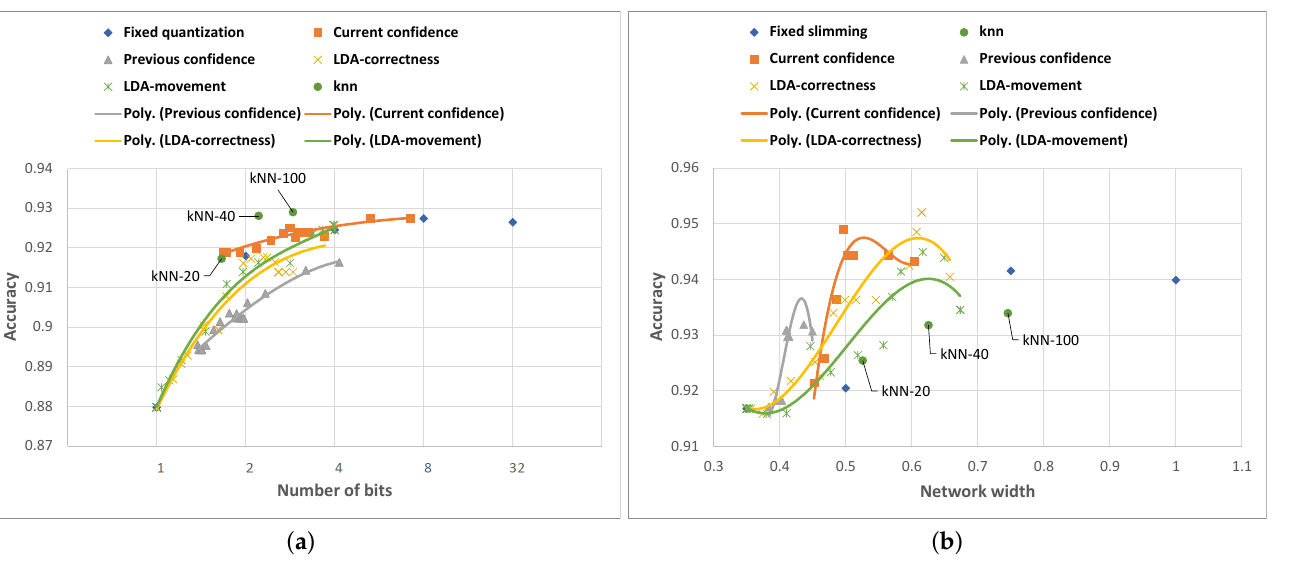
Figure 12. Comparative illustration of the results of the three compression selection algorithms on the UCI HAR dataset, for both Any-Precision ResNet-50 and SNN MobileNet-V2. ( a ) Any-Precision. ( b )